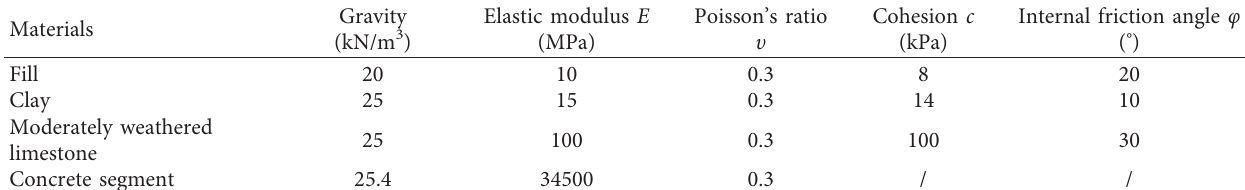
Table 1: Mechanical parameters of geotechnical materials in the